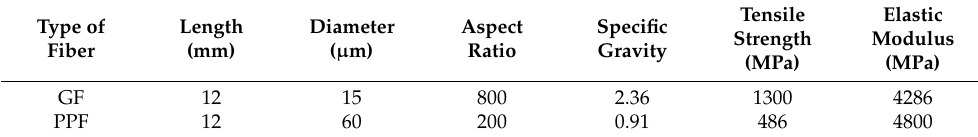
Figure 1. Appearance of the used fibers: ( a ) GF and ( b ) PPF. Table 6. Properties of GF and